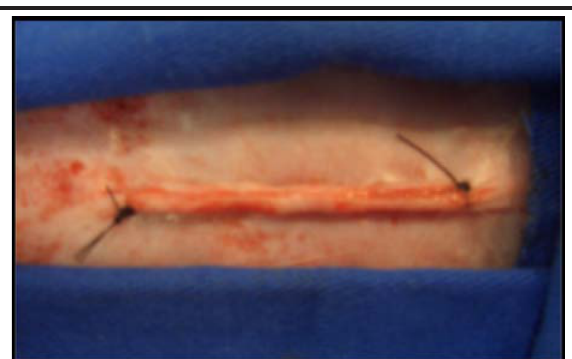
FIGURE 8 - Rupture, under stress, of the sample studied. Polypropylene